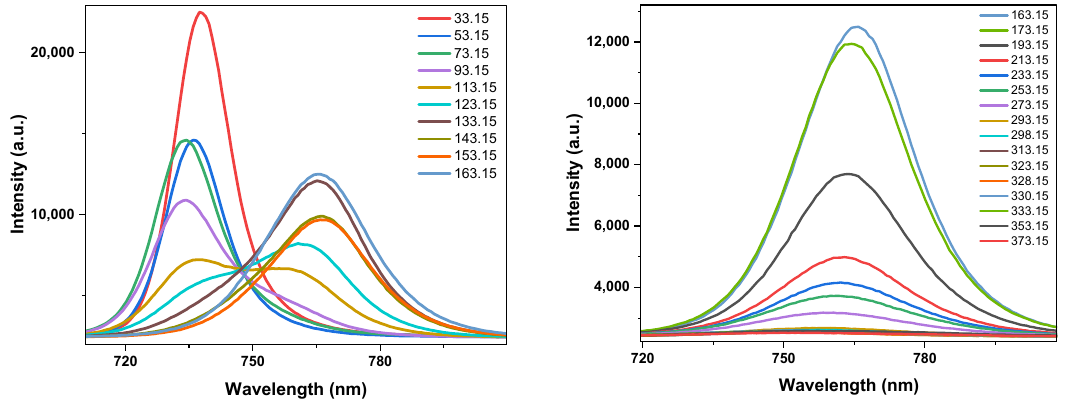
Figure 7. PL spectra of MAPbI 3 in the temperature range 33–353 K. excitation laser intensity of 7.9 mW cm − 2 by 473 nm CW laser.